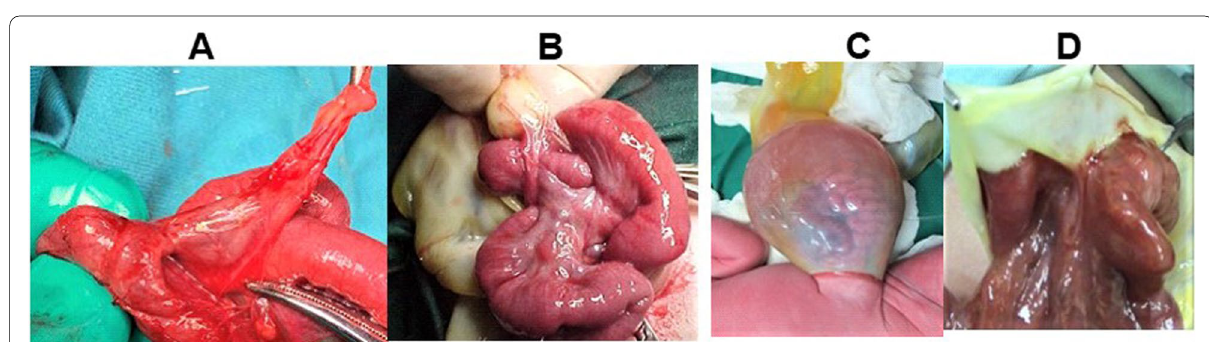
Fig. 3 Hernia of the umbilical cord (HUC) with irreducibility due to A adhesions fixing Meckel’s diverticulum and adjacent ilium to hernial sac, needed release of the adhesions and excision of Meckel’s diverticulum. B Fibrous adhesive bands in the sac intermingling loops of ilium preventing the loops to be reduced, needed surgical interventions (release the adhesive bands). C Ileal loops trapped in the sac by peritoneal septum at umbilical ring (adhering to narrow ring), needed exploration of the sac and dilatation of sac neck and reduction of content, repair, and umbilicoplasty. D Sliding hernia where loops of ilium forming the sac wall needed to be dissected from the sac to be